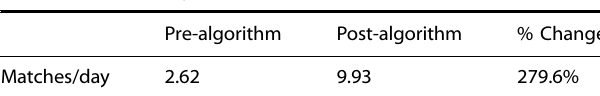
Table 4. Pre/Post Algorithm Matches.